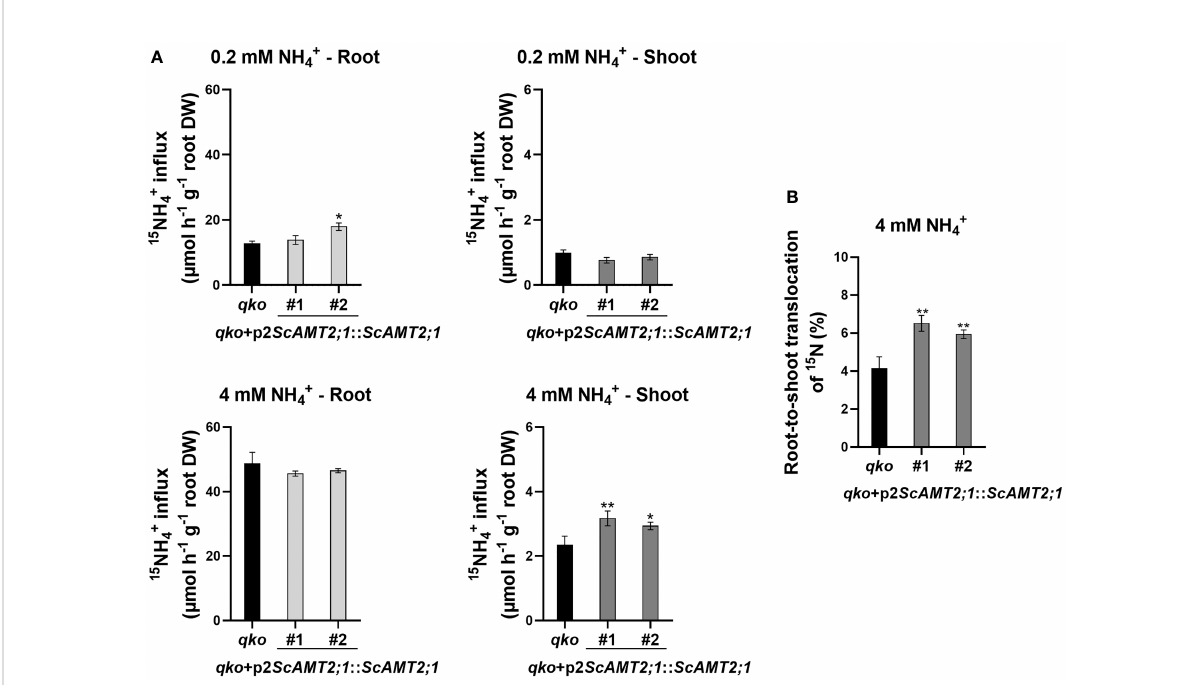
FIGURE 7 15 N accumulation in roots and shoots of qko and complemented qko transgenic lines expressing ScAMT2;1 under the regulation of its sugarcane endogenous promoter (p2). The assay was performed in plants after 3 d of exposure to an N-free nutrient solution, followed by 1 h of treatment in either a 0.2 mM or 4.0 mM 15 NH 4+ solution. Bars indicate means ± SE ( n = 5). Asterisks indicate signi fi cant differences in root and shoot 15 NH 4 + accumulation between qko and transgenic plants according to Student ’ s t test (* p < 0.1 and ** p < 0.05). (B) Root-to-shoot translocation of 15 N in percent of 15 N accumulation in shoots in relation to the whole plant. Asterisks indicate signi fi cant differences between qko and transgenic plants according to Student ’ s t test (** p <